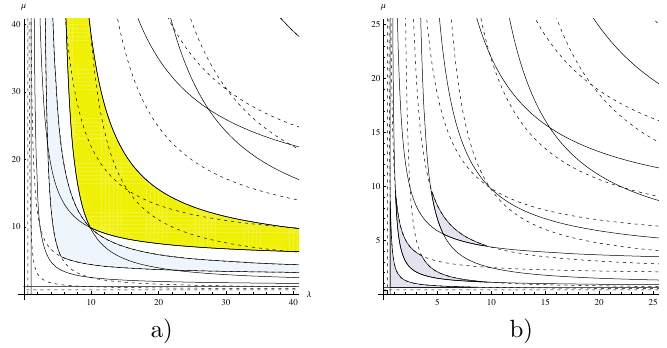
Figure 3. Several first branches of the Fuˇc´ık spectra for problems (3.1) (dashed curves) and (3.2) (solid curves) are given; a) D ( k ) 3 (on the left) and D ( l ) 3 for k/l = (4 / 3) 2 are shaded, and their intersection is empty (a “common” point does not belong to (cid:2) (cid:2) (cid:2) D ( k ) 3 D ( l ) 3 since both sets are open; b) “Good” regions D ( l ) 0 D ( k ) 0 , D ( l ) 1 D ( k ) 1 , (cid:2) (cid:2) D ( l ) 2 D ( k ) 2 and D ( l ) 3 D ( k ) 3 for k/l = (5 / 4) 2